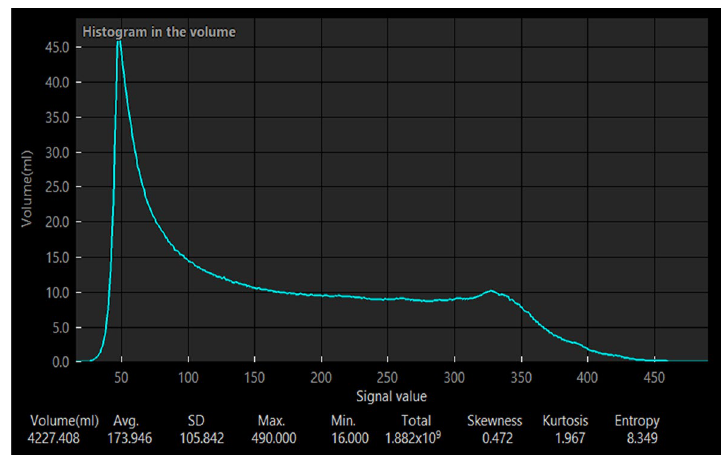
Fig. 3 A histogram of radioactivity volume generates from 99m Tc-MAA SPECT. The x-axis represents the count from 99m Tc-MAA SPECT. The y-axis represents the volume per count. The lung volume was measured as the percentage area with radioactivity higher than the cutoff level of 10% of the maximum count on a histogram. In this case, the count at the edge of the lung perfusion SPECT was 49. Therefore, the total lung volume was calculated by adding up the volume per count from 49 to max count. Abbreviations: 99m